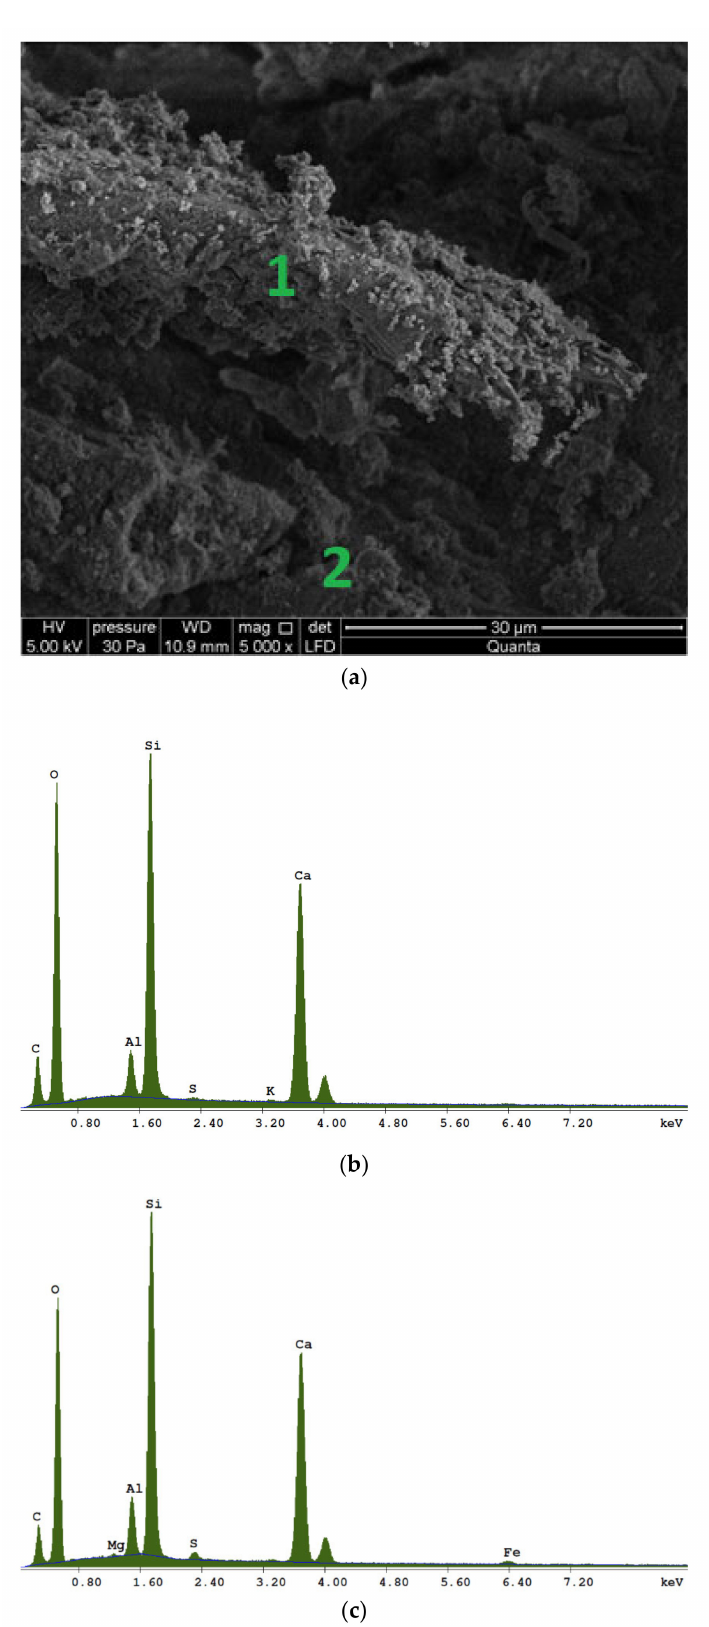
Figure 2. EDS analysis results for a mock sample: ( a ) distribution of measuring points; ( b ) analysis results from point 1—fiber; ( c ) Analysis results from point